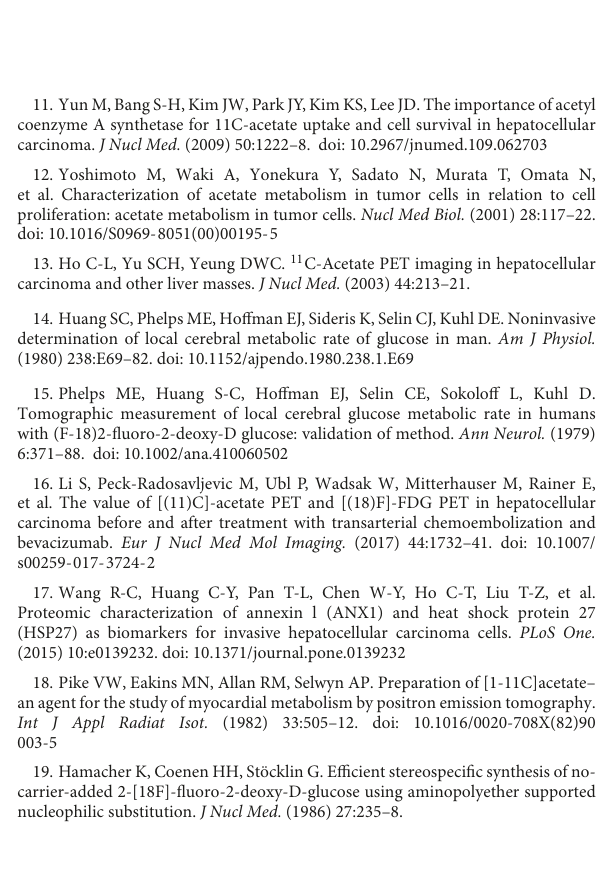
enzymes for possible drug targets (red box; FASN, ACLY, and ACSS2 were analyzed in this study). In this study, we examined the treatment response of HCC to Orlistate treatment (FASN